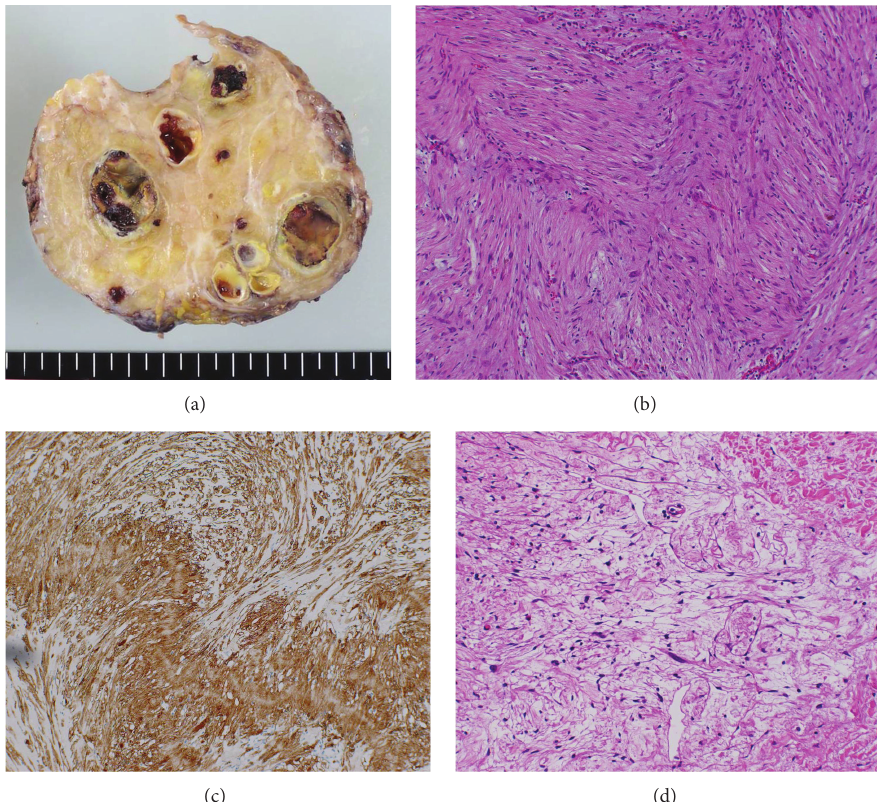
Figure 3: (a) Cut surface of the tumor shows encapsulated solid mass containing multiple eggshell-like calcifications. (b) Microscopic image (HE, magnification × 100) shows palisaded arrangement of spindle-shaped cells. (c) Immunohistochemically, tumor cells are positive for S-100 protein. (d) Myxoid degeneration and hyalinization are focally seen in the